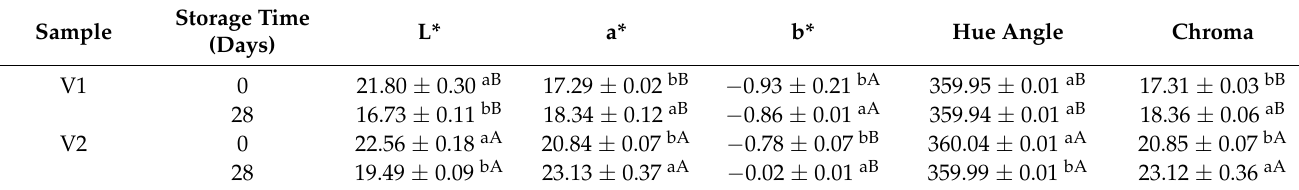
Table 2. Color parameters (L*, a*, b*, hue angle, and Chroma) of the